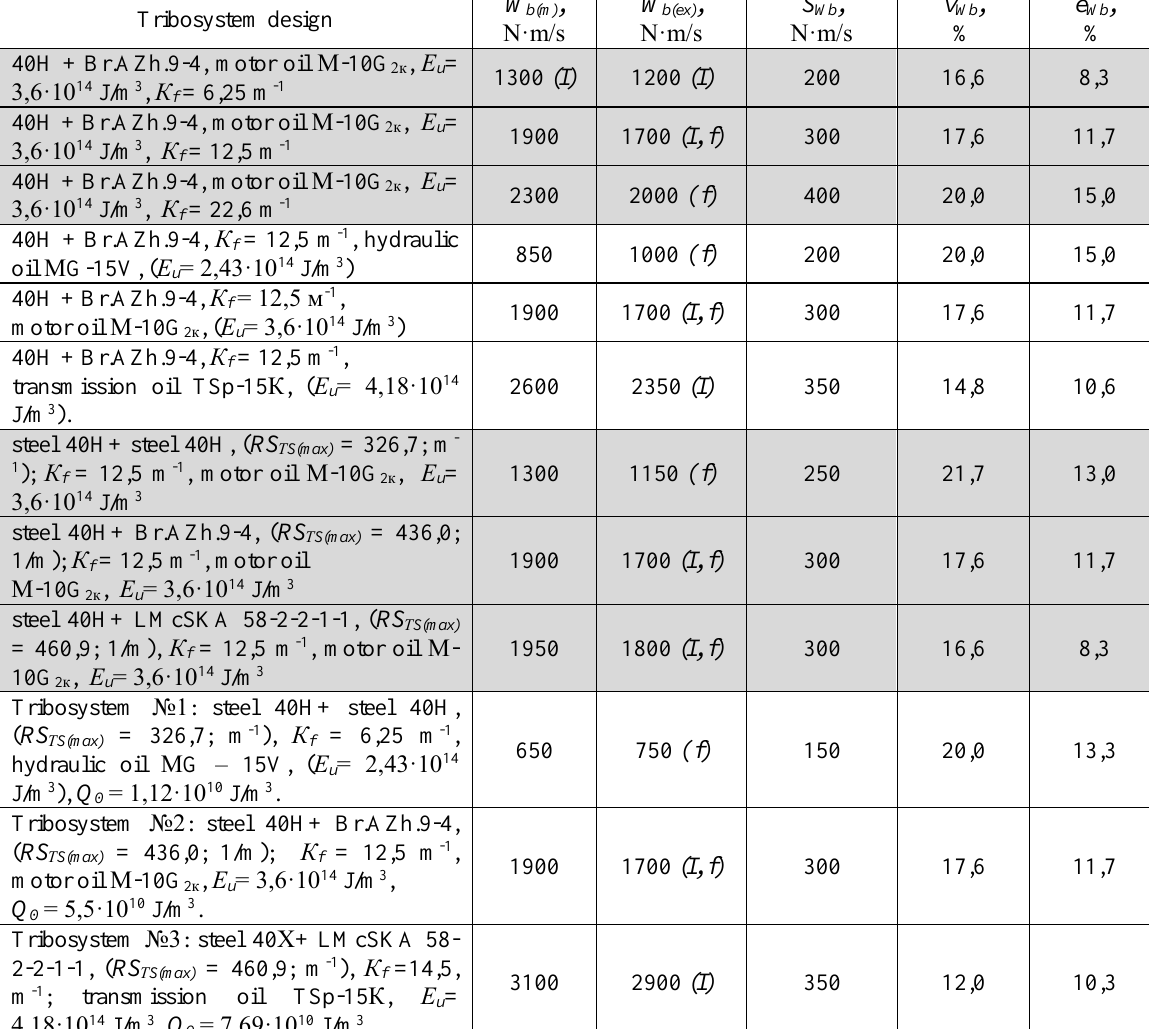
The results of checking the error of modeling the range of robustness of different designs of tribosystems Tribosystem